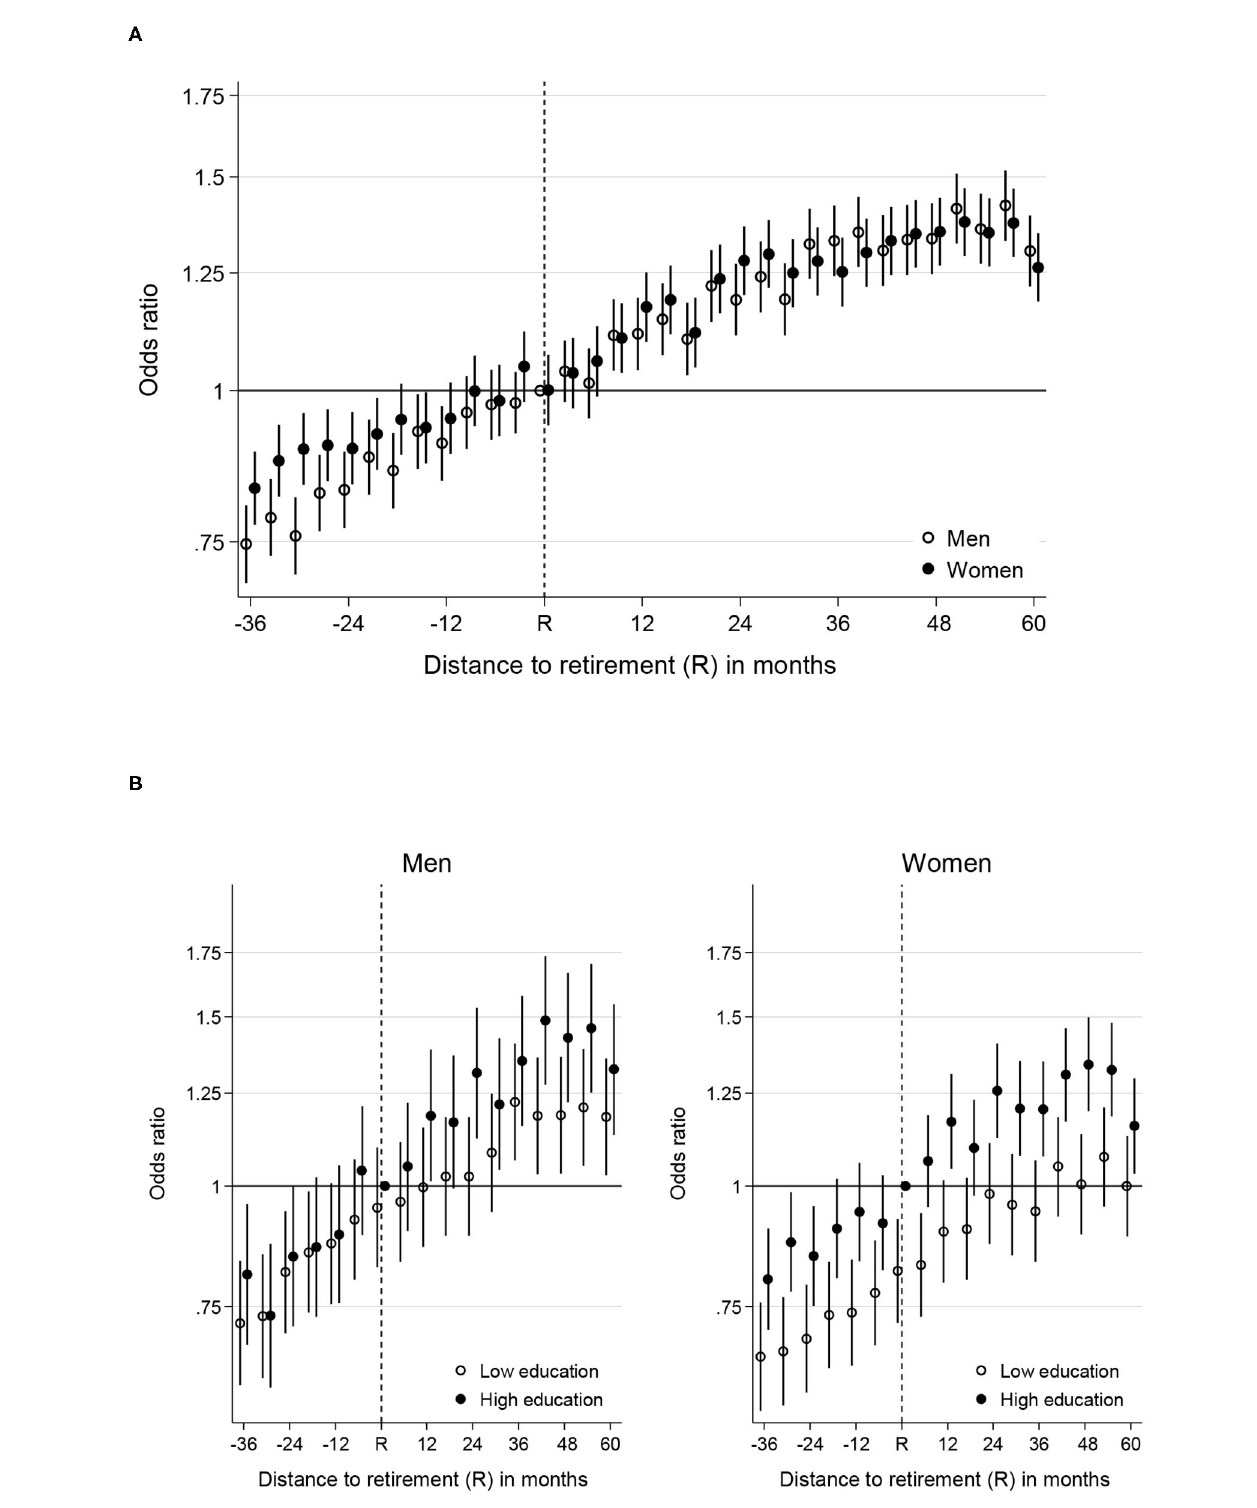
FIGURE 1 | (A) Likelihood of specialist visit (expressed as odds ratio) during the retirement transition for men and women. Reference category is recently retired men. (B) Likelihood of specialist visit (expressed as odds ratio) during the retirement transition by gender and education. Reference category is recently retired high educated men or women. Only data from the low and high education groups and every second measurement occasion are displayed.